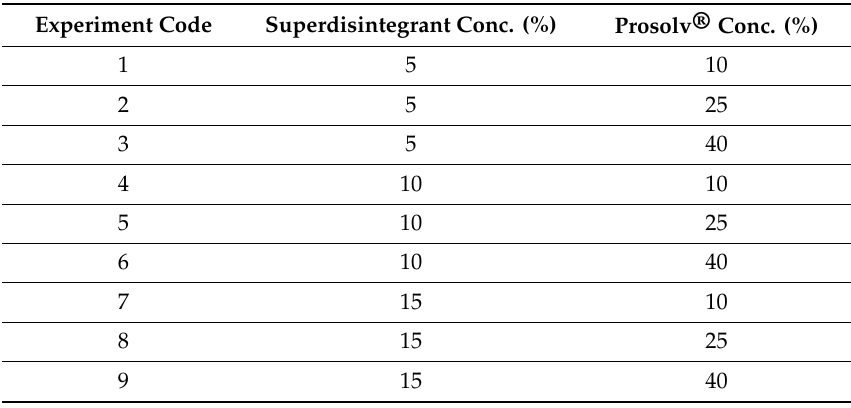
Table 7. A full matrix of 3 2 full factorial design for Sulpiride FDT formulations.